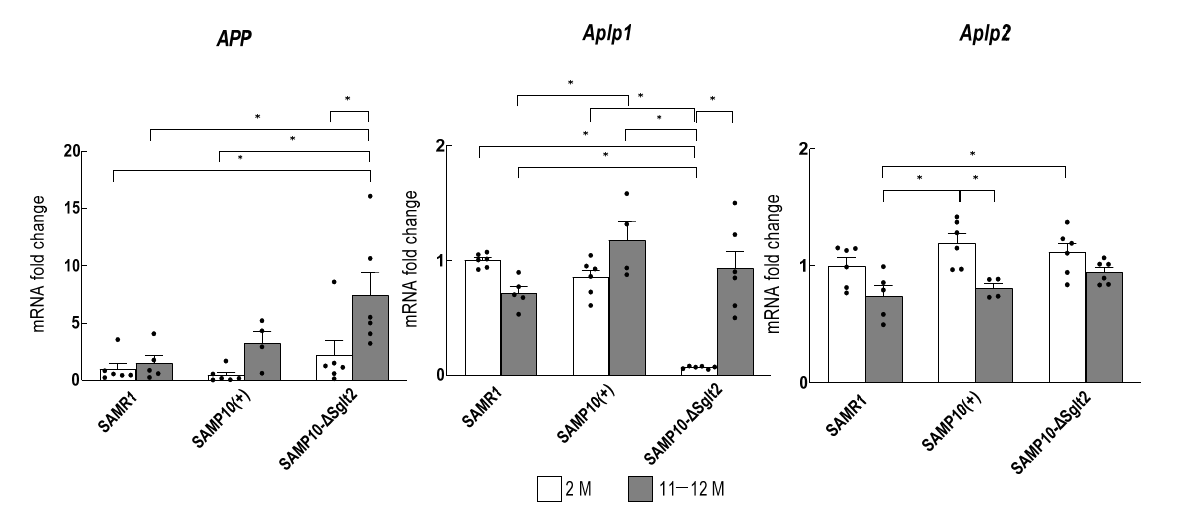
Figure 1. Expression of APP , Aplp1 , and Aplp2 in hippocampi of male SAMP10- ∆ Sglt2, SAMP10(+), and SAMR1. The levels were measured at 2 and 11–12 months of age ( n = 4–6, * p < 0.05). qRT-PCR analysis was performed using Power Up SYBR Green Master Mix (A25742, Applied Biosystems Japan Ltd., Tokyo, Japan) and an automated sequence detection system (Step One, Applied Biosystems). The relative expression of the APP and Aplp2 gene was determined using the previously validated primers [61,62]. β -actin was used as an internal control. Data for Aplp1 were taken from the results in [62]. Data are expressed as means ± SEM overlaid on scatter plots. Black dots indicate values for each mouse. The data were analyzed by ANOVA followed by the Tukey–Kramer